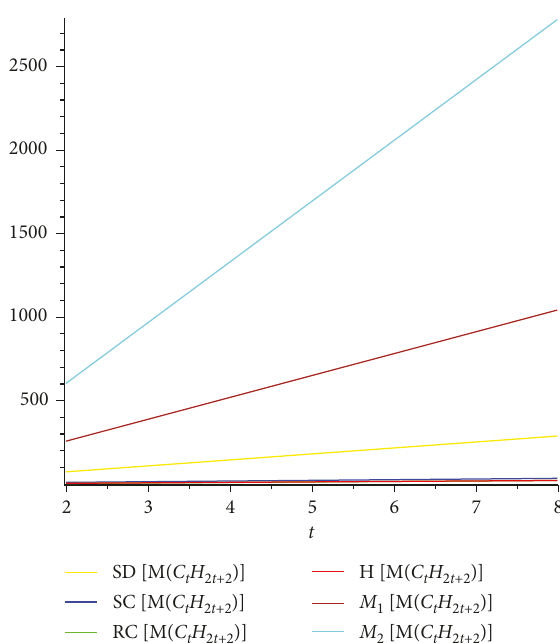
Figure 3: Graphically representation of middle graph of alkane ( C